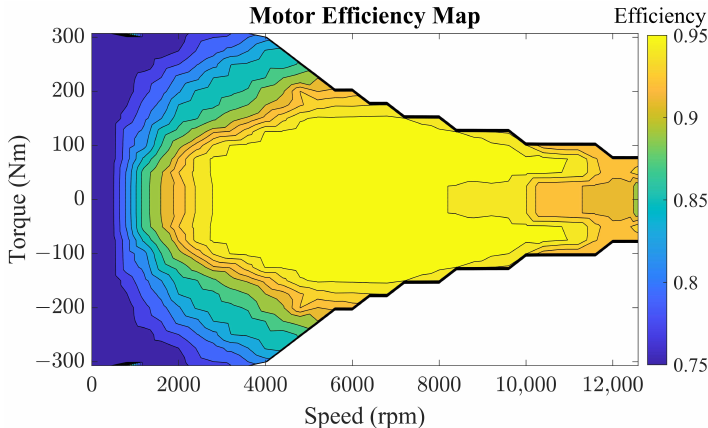
Figure 3. The motor efficiency